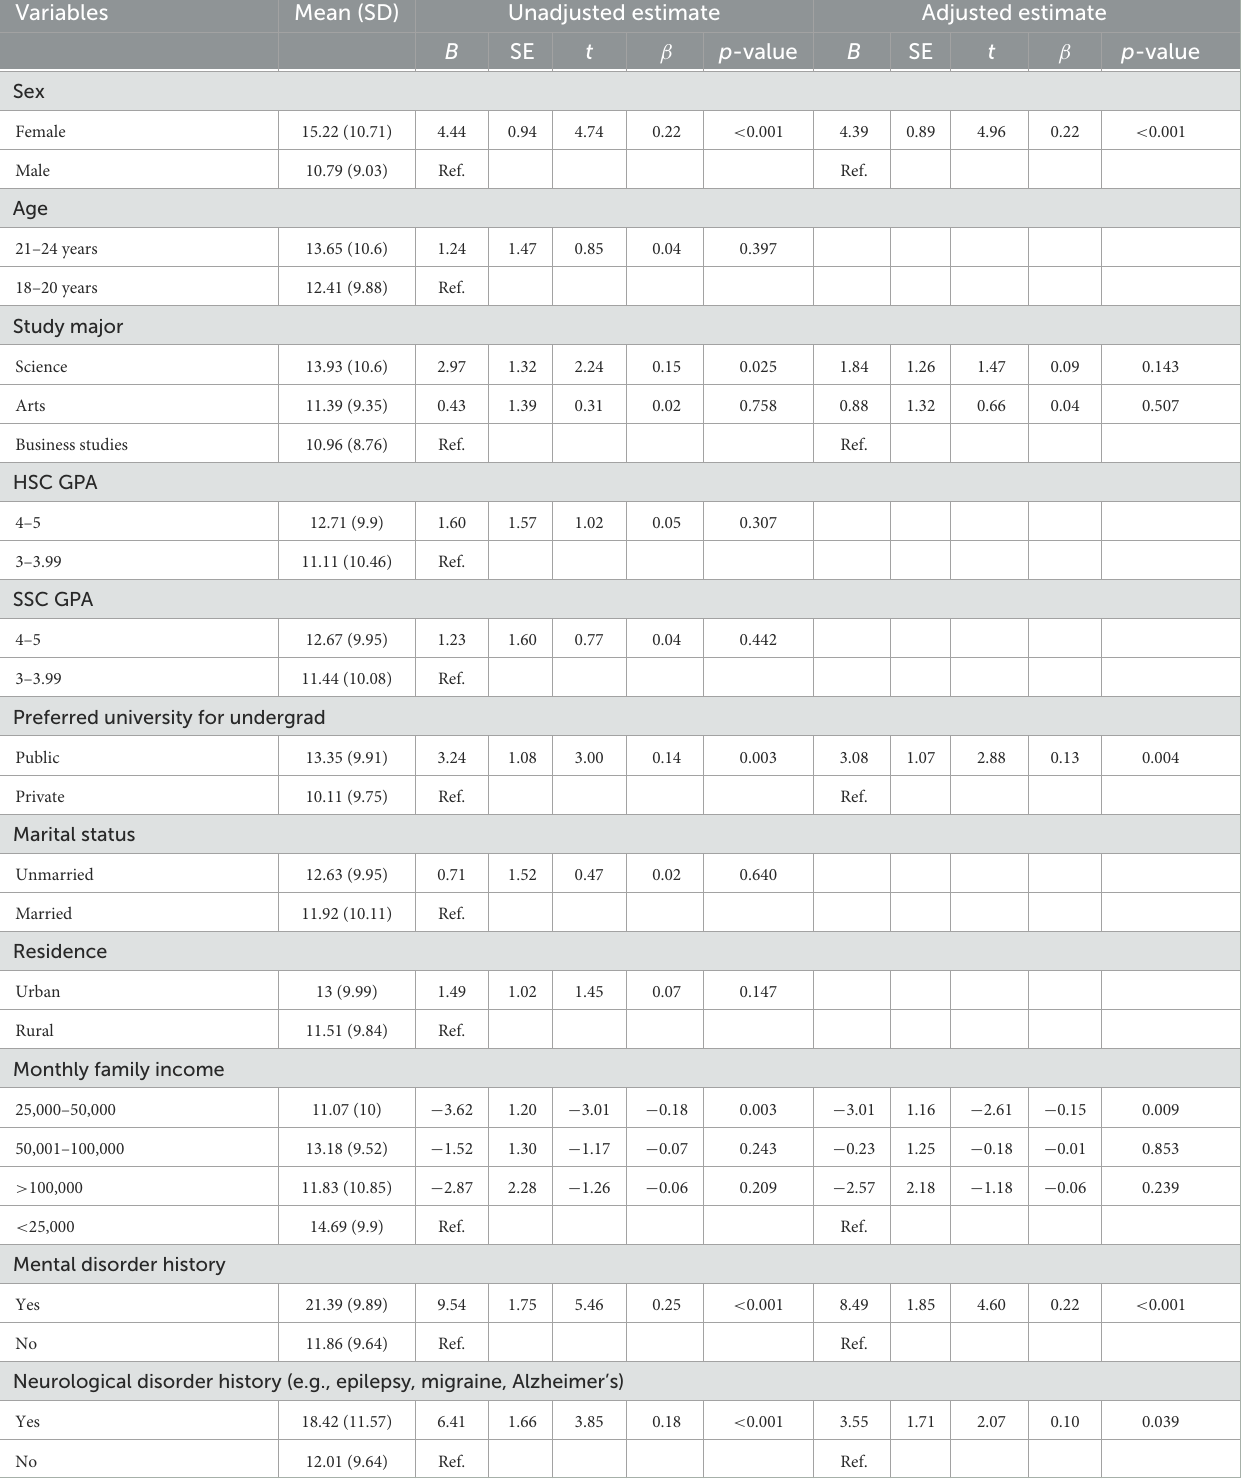
TABLE 3 Bivariate and multivariable regression analyses by anxiety score.